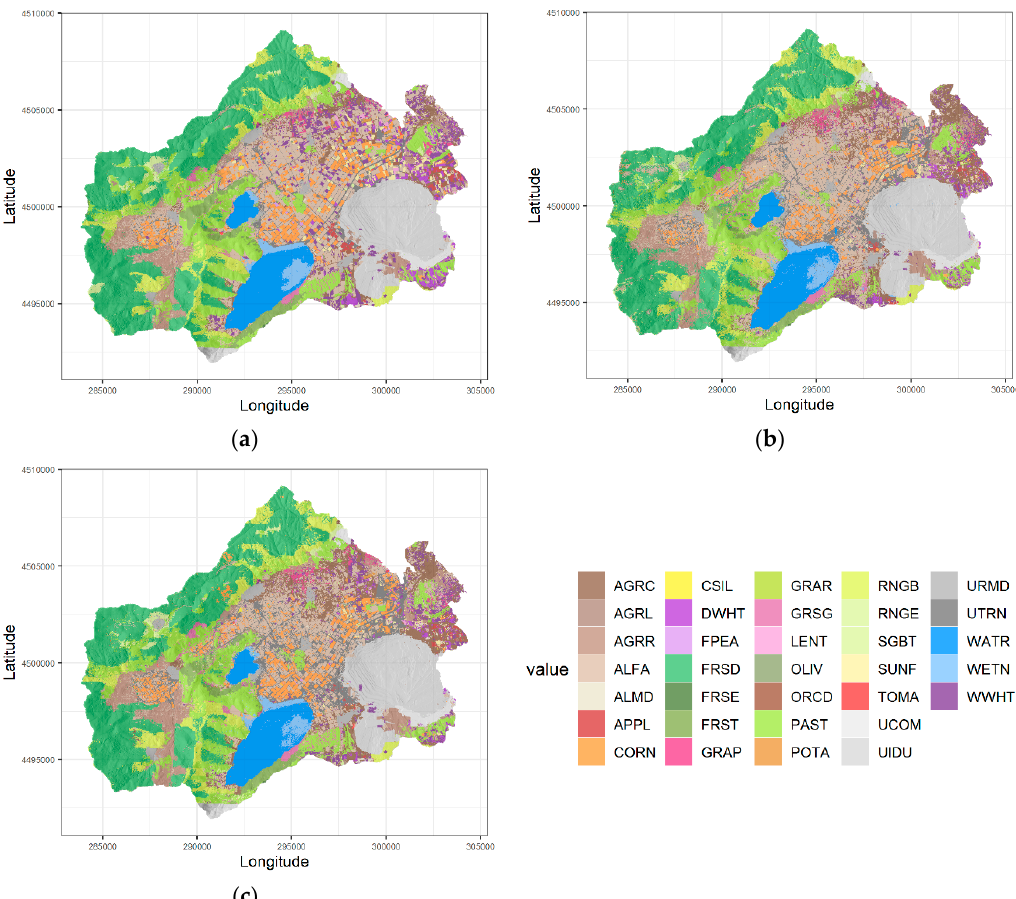
Figure 6. Land Cover Maps produced by using the convolutional neural network CNN classification algorithm. Each map indicates the classification at annual basis in the Lakes Zazari-Chimaditida catchment. ( a ) 2017, ( b ) 2018 and ( c ) 2019.